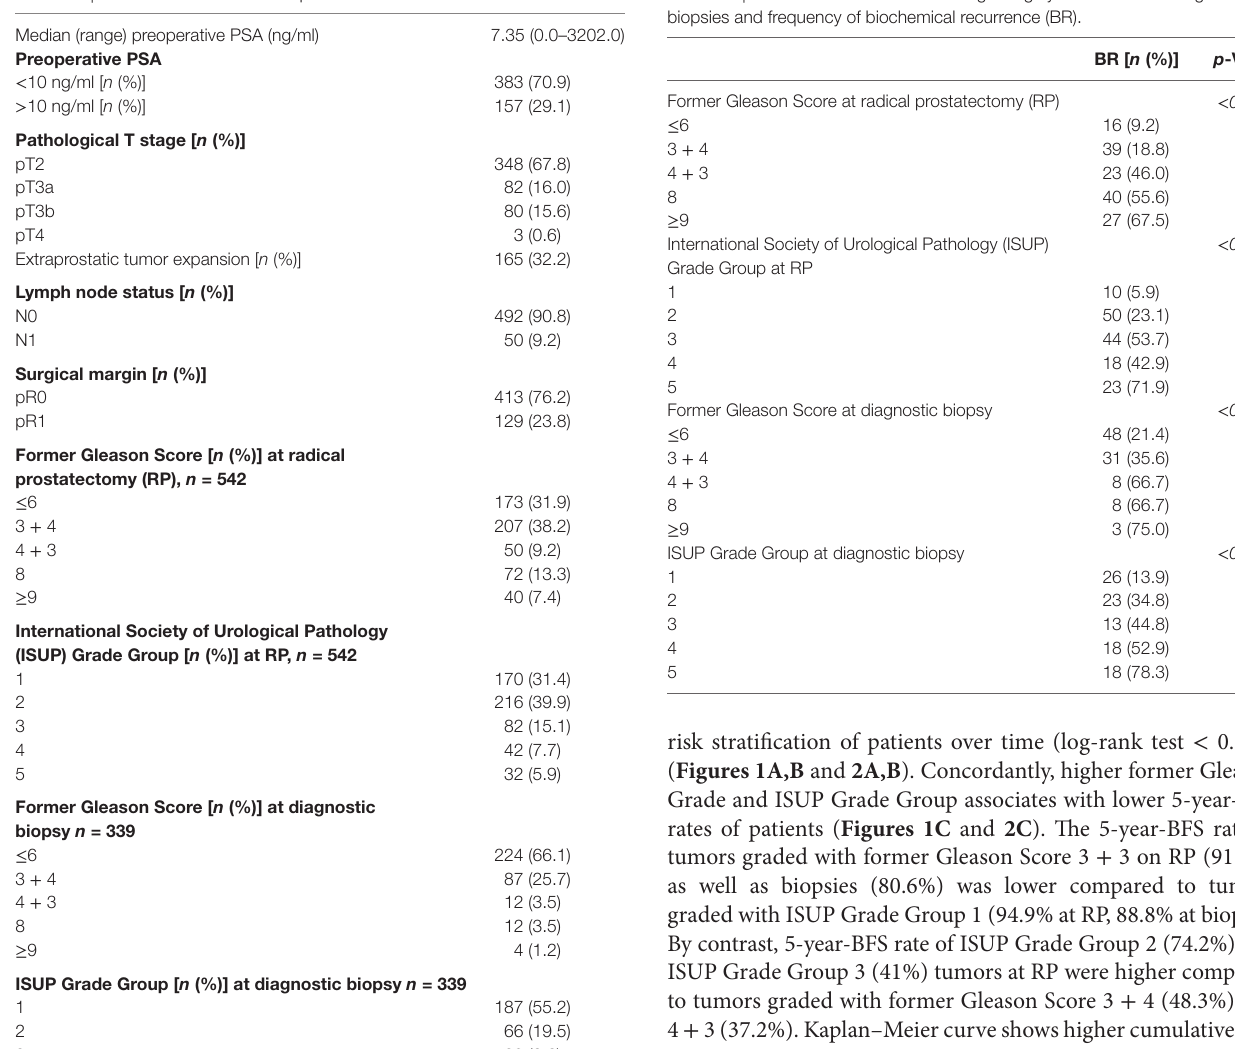
Table 1 | Baseline characteristics of